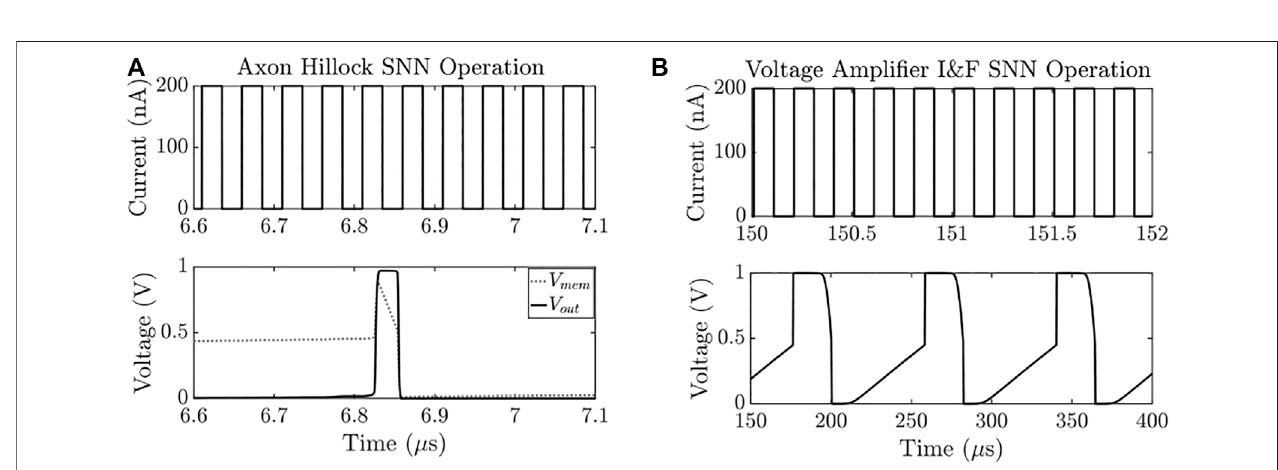
FIGURE 3 | Simulation result of (A) Axon Hillock spike generation showing input current ( I in ) (top plot), the membrane voltage ( V mem ), and the output voltage ( V out ) (bottom plot); and (B) voltage ampli fi er I&F neuron spike generation showing input current ( I in ) (top plot and zoomed-in), and the membrane voltage ( V mem ) (bottom plot).